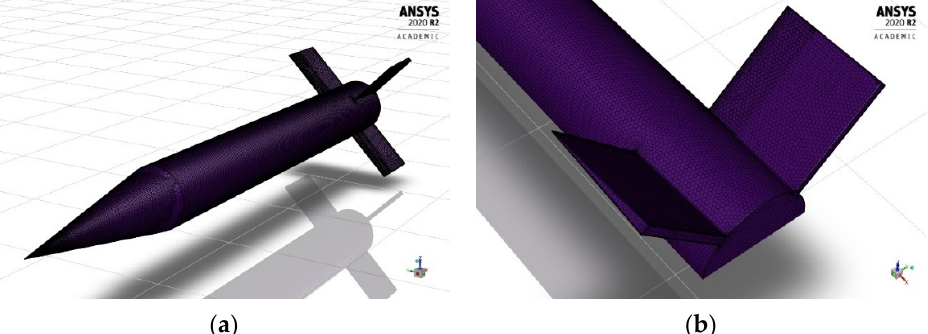
Figure 2. ( a ) Axis system on unstructured surface mesh of ANF missile; ( b ) 45 deg missile rotation along x ‐ axis for tests ‐ conduct condition. Table 1. Oscillation user ‐ defined input (UDF) for pitching, plunging, and flapping modes. Mode